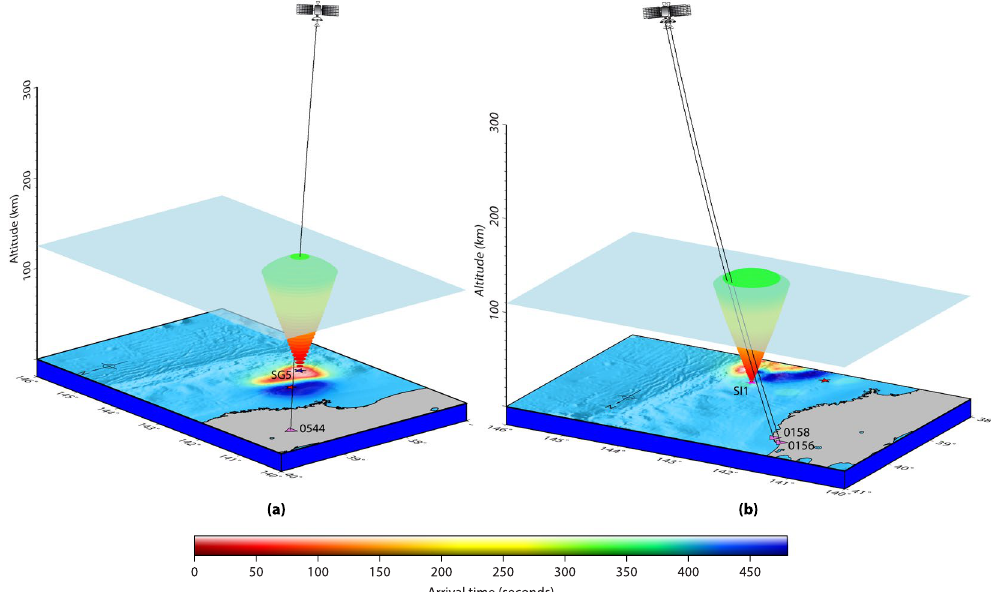
Figure 3. 3D model identifying the seismic sources of CIP detected by PRN 05 from GPS stations of ( a ) 0544 and ( b ) 0156 and 0158. The evolution of seismo-acoustic rays is shown in 3D space and time. Triangles represent the GPS stations. The satellite is illustrated in the orbital plane of ~22,000 km (not to the scale). The first interaction of PRN 05 LOS from 0544 station and seismo-acoustic rays from SG5 source could be noticed in ( a ). The interaction occurs at ~126 km of altitude within ~420 s of the event. The interaction altitude is represented with a transparent 3D plane for easier visualization. PRN 05 LOS from 0156 and 0158